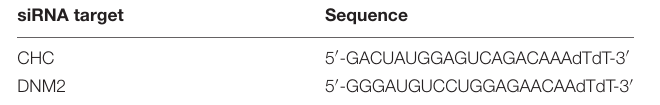
TABLE 1 | Targeted sequence information of specific siRNAs. siRNA target